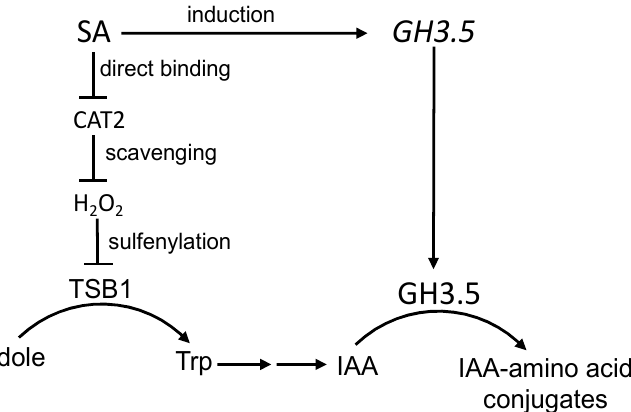
Figure 2. Regulation of auxin biosynthesis and metabolism by SA. SA directly binds to and inhibits CAT2 to increase H 2 O 2 levels, which promotes sulfenylation of an IAA biosynthetic enzyme, TSB1, to inhibit its activity, thereby reducing IAA production. SA also induces the expression of GH3.5 , which encodes an acyl acid amido synthetase that conjugates amino acids to IAA, causing its inactivation or degradation.